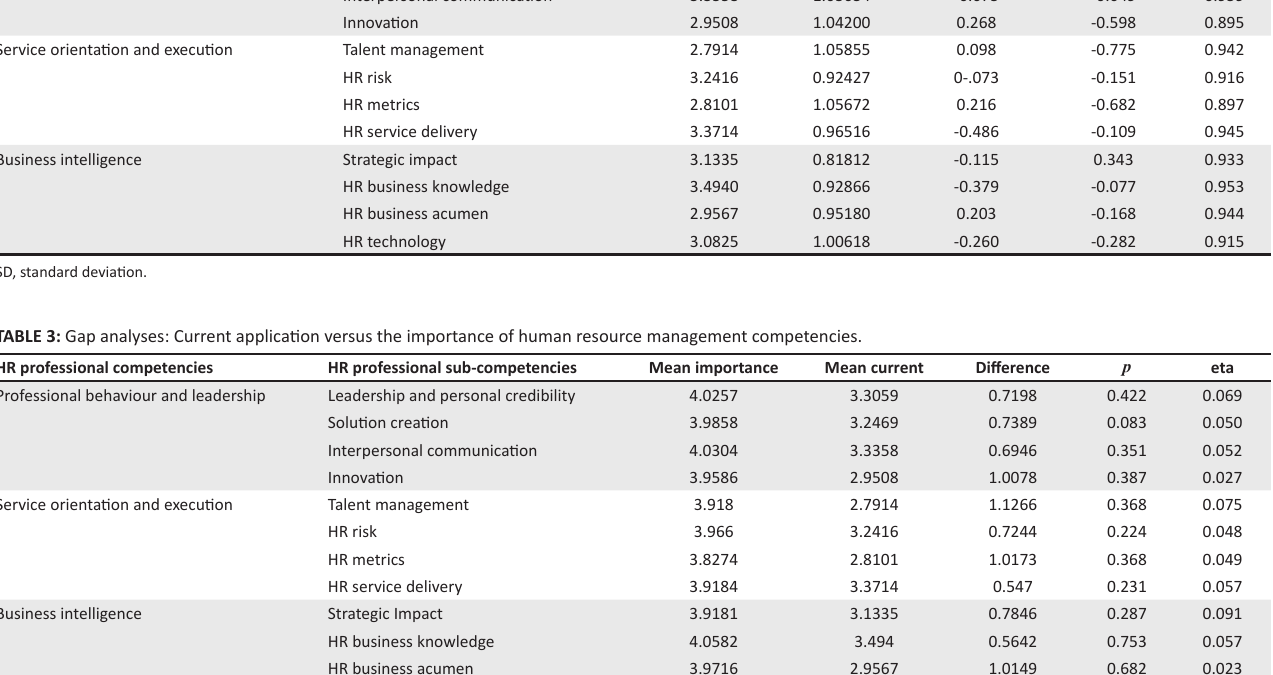
the variance for the measure. The factors were labelled ‘talent